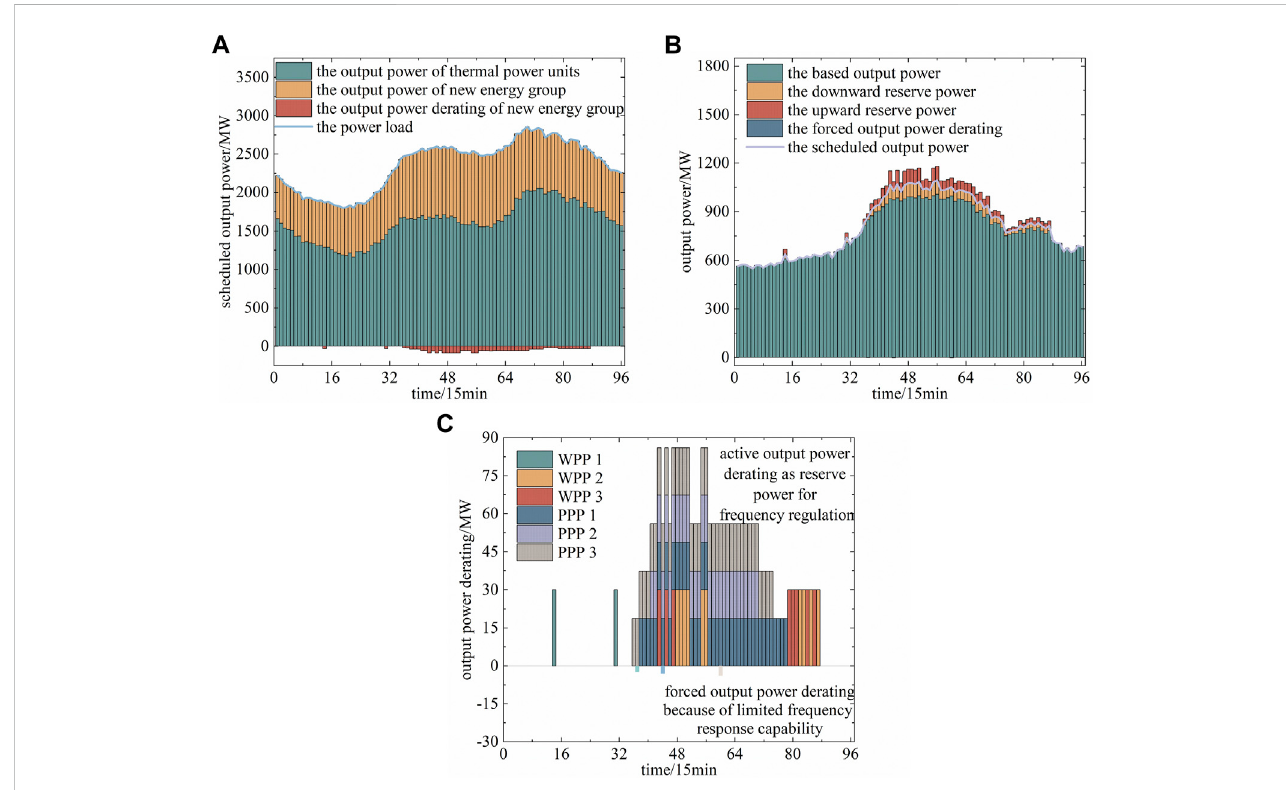
FIGURE 8 System scheduling results: (A) scheduled result of the system, (B) scheduled result of the new energy, and (C) output power derating of new